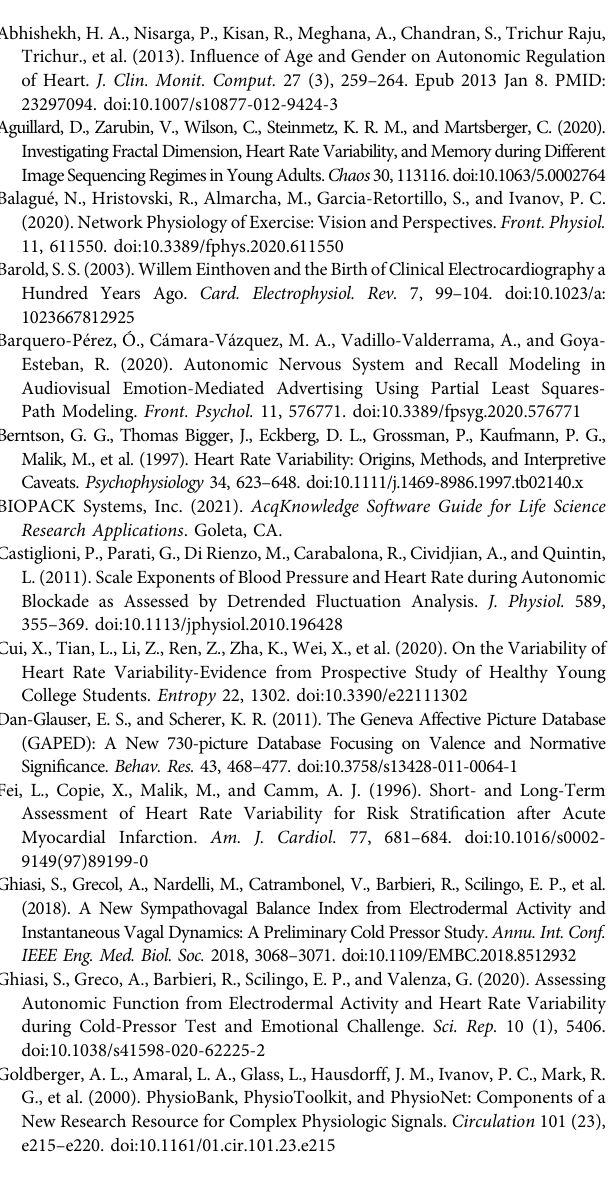
Supplementary Table S1 | DFA α 1 comparisons during each image viewing type within pure regime participants.